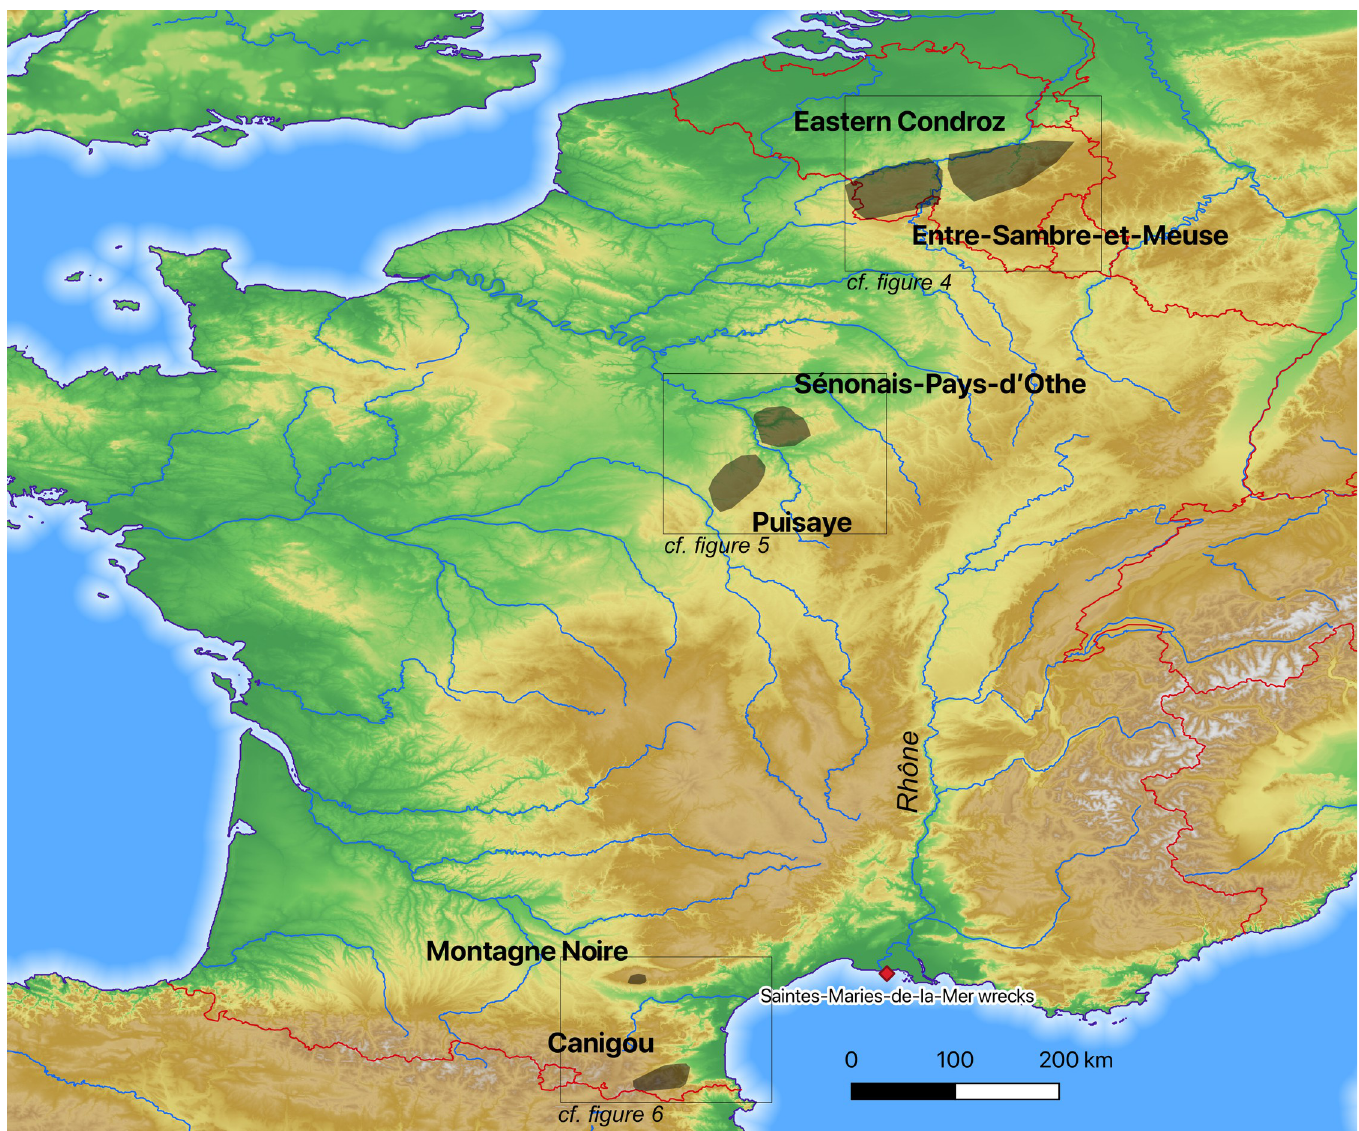
Fig 3. Locations of the iron production areas (north at the top; DEM NASA Shuttle Radar Topography Mission Global 1 arc second).